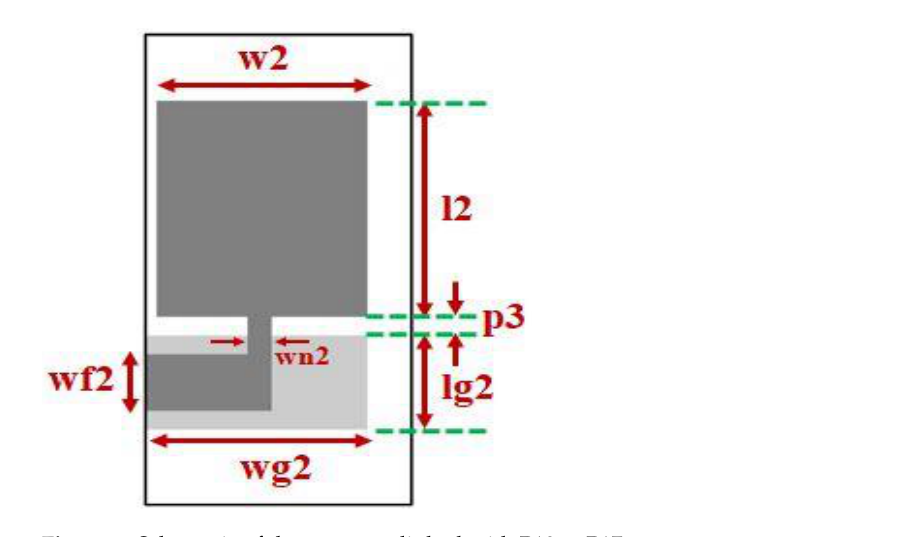
9 of 27 Figure 8 . Reflection coefficients of the antenna linked with port 2 for different values of ln1 .